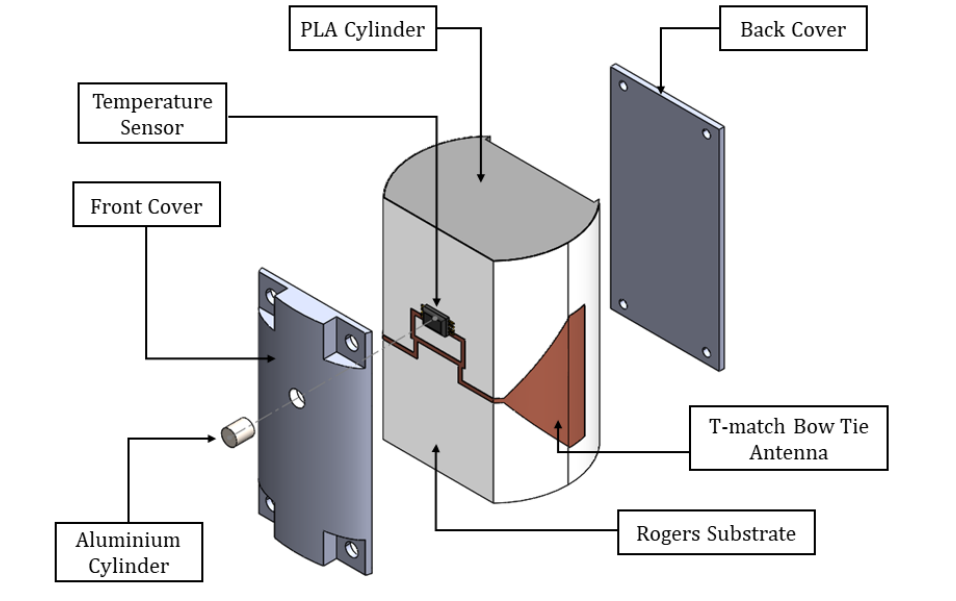
Figure 2. Wrapped RFID antenna. Bow tie with